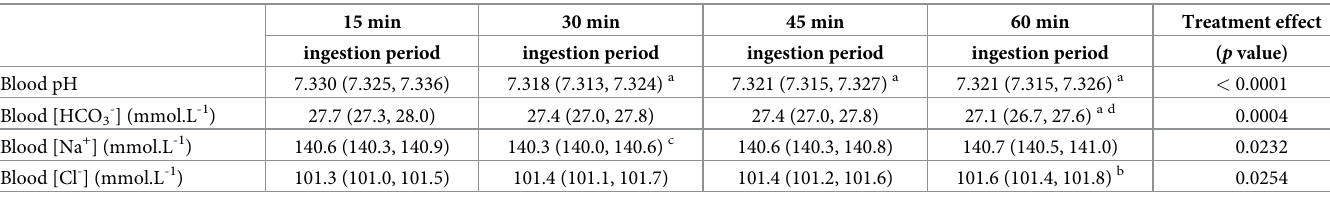
exceed 1.2 out of a maximum of 40 at any given measurement time (Fig 3A). The most fre- quently reported symptoms (irrespective of severity) were sickness and nausea, reported by between four and six of 16 participants per session (Fig 3C). No differences were detected between treatments for palatability (score) (Table 4 and S4 Table).